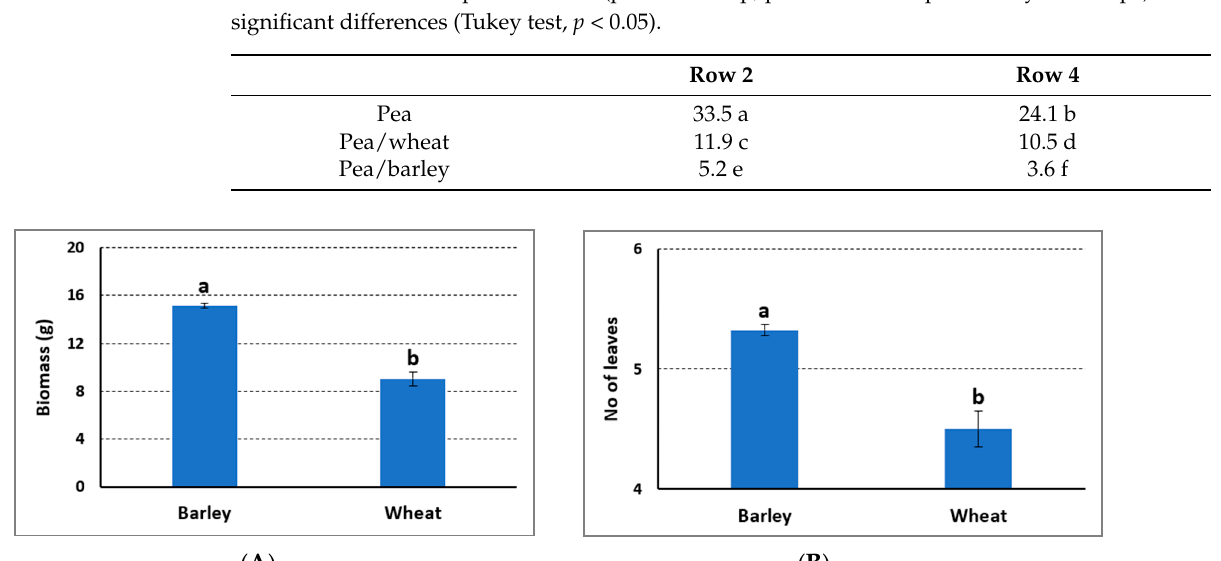
Figure 6. Dry biomass ( A ) and number of leaves ( B ) of barley and wheat in the experiments under controlled conditions. Different letters mean significant differences (Tukey test, p < 0.05). Bars for standard errors are shown. Table 6. Powdery mildew disease severity (%) on pea seedlings grown in rows 2 and 4 of the boxes. Different letters per treatment (pea monocrop, pea/wheat and pea/barley intercrops) mean significant differences (Tukey test, p < 0.05).